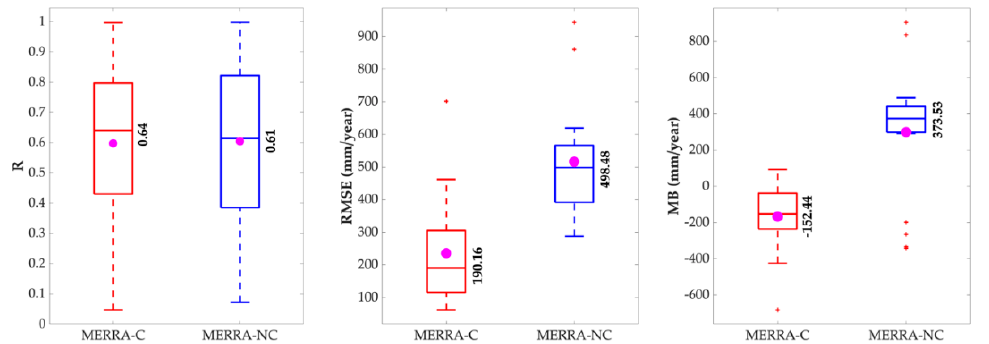
Figure 3. Boxplots for performance metrics (R, Root-Mean-Square Error (RMSE), mean bias (MB)) of MERRA-2 (MERRA-C and MERRA-NC) with observed datasets for annual timescale. The bold values and magenta dot in the boxplot represent the median and mean values of the statistical metrics, respectively.